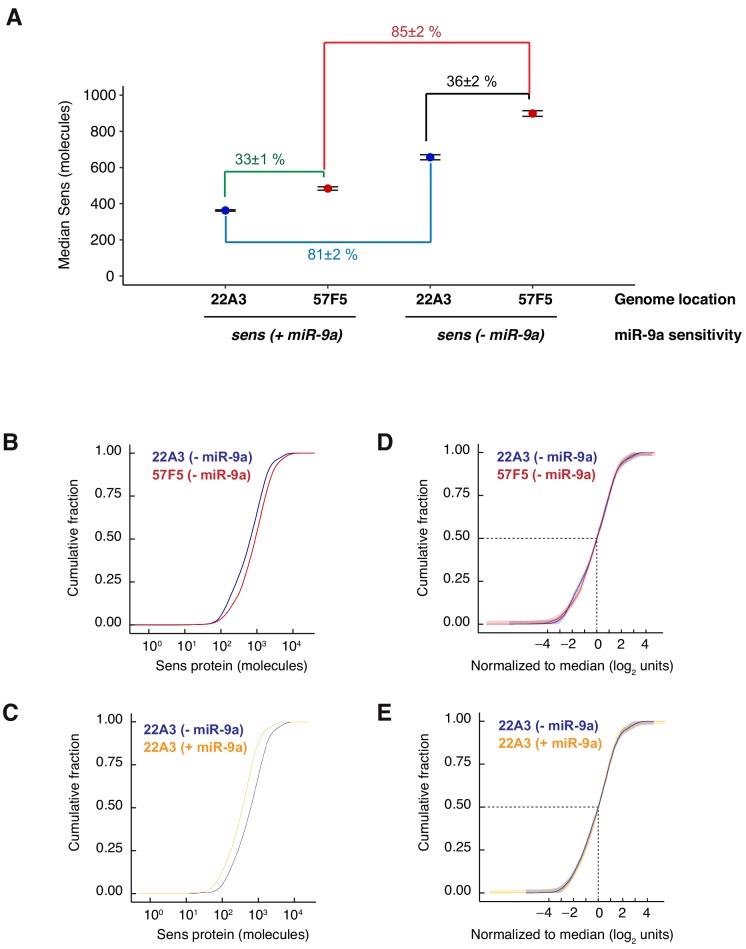
Comparison of Sens expression profiles for various allelic pairs.(A) Median protein number per cell for total Sens (sfGFP-Sens + mCherry-Sens) expressed from allelic pairs inserted at either 22A3 or 57F5; with or without the miR-9a binding sites in the 3’UTR. Error bars are 95% confidence intervals. Percentages represent the percent increase in median number from lower to higher expressing conditions. (B,C) Empirical cumulative density profiles (CDFs) of Sens protein number per cell for the conditions comparing (B) insertion site and (C) miR-9a regulation. (D,E) CDFs in B and C were normalized by their respective median protein numbers and log2 transformed. Dashed lines mark the normalized median number per cell, corresponding to log2(1)=0. Shaded regions depict the upper and lower 95% confidence intervals computed for each CDF by Kolmogorov-Smirnov’s D statistic.